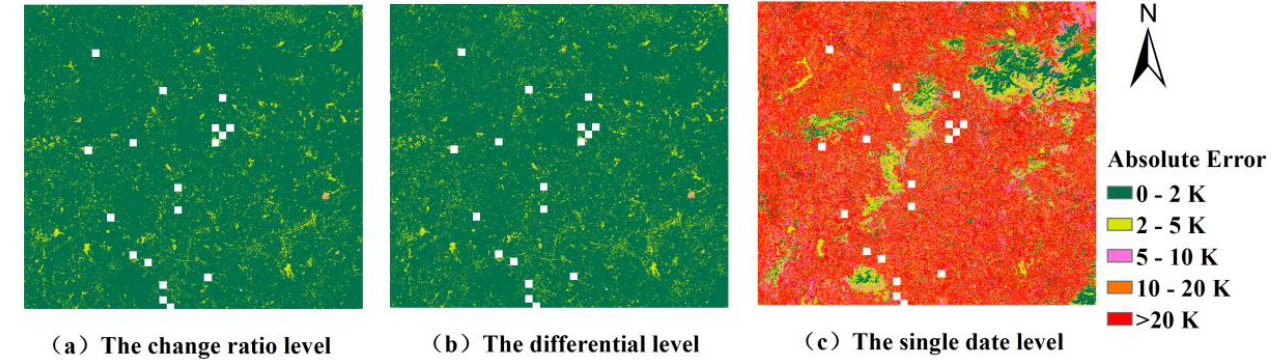
Figure 7. Comparison of the absolute error distribution of model fusion results based on unmixing on the single date level ( a ), the differential level ( b ), and the change ratio level ( c ) on 20 November 2001.